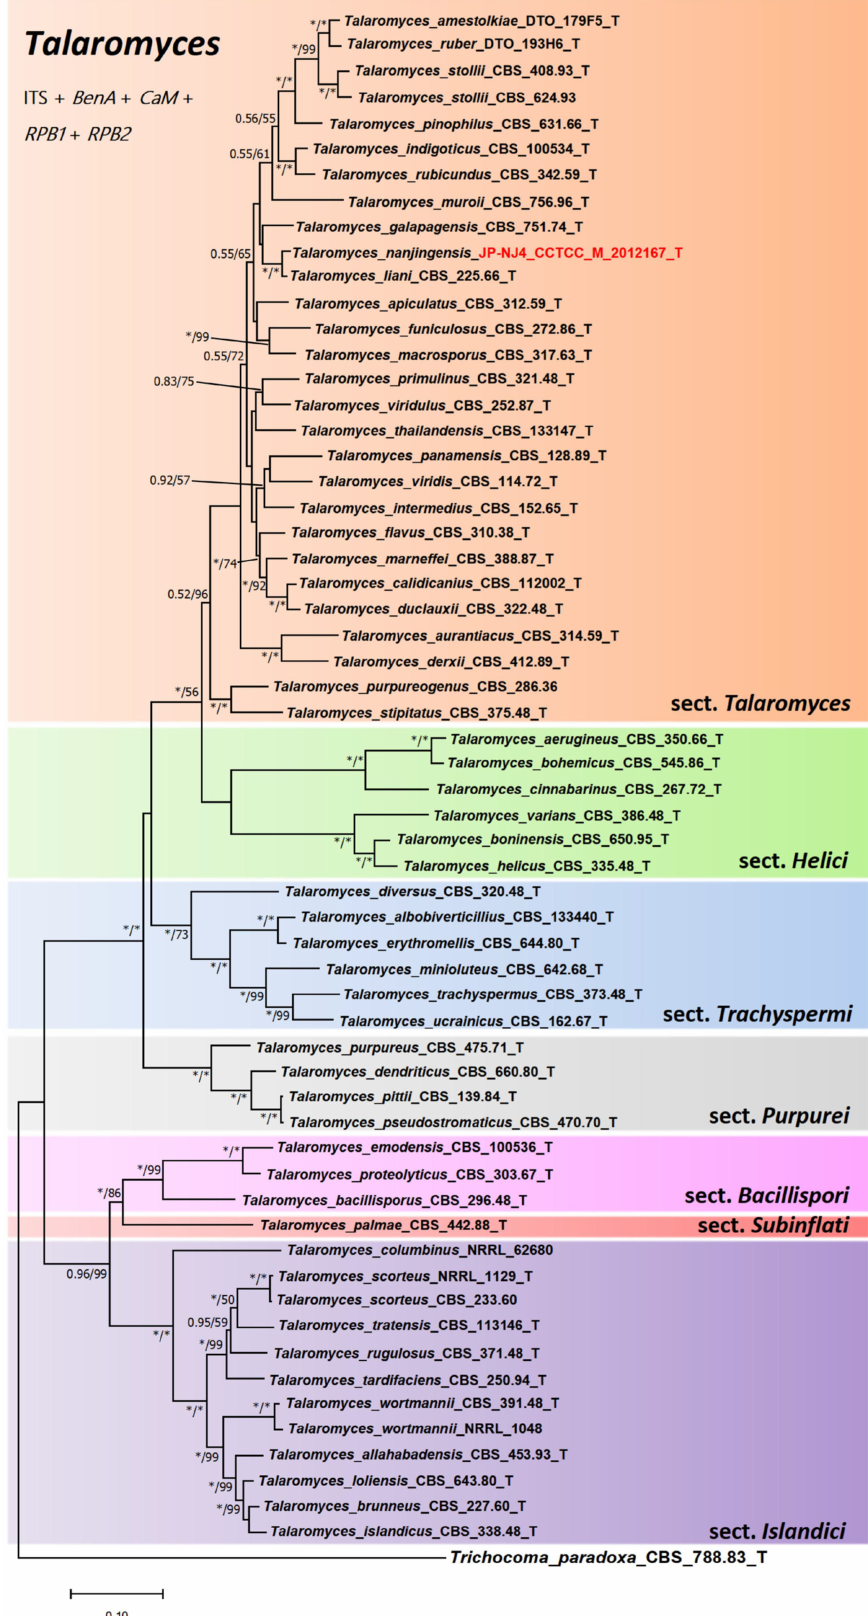
Figure 1. Combined phylogeny of the ITS, BenA , CaM , RPB1 , and RPB2 gene regions of species from Talaromyces . Maximum likelihood tree of strain JP-NJ4 was constructed. Trichocoma